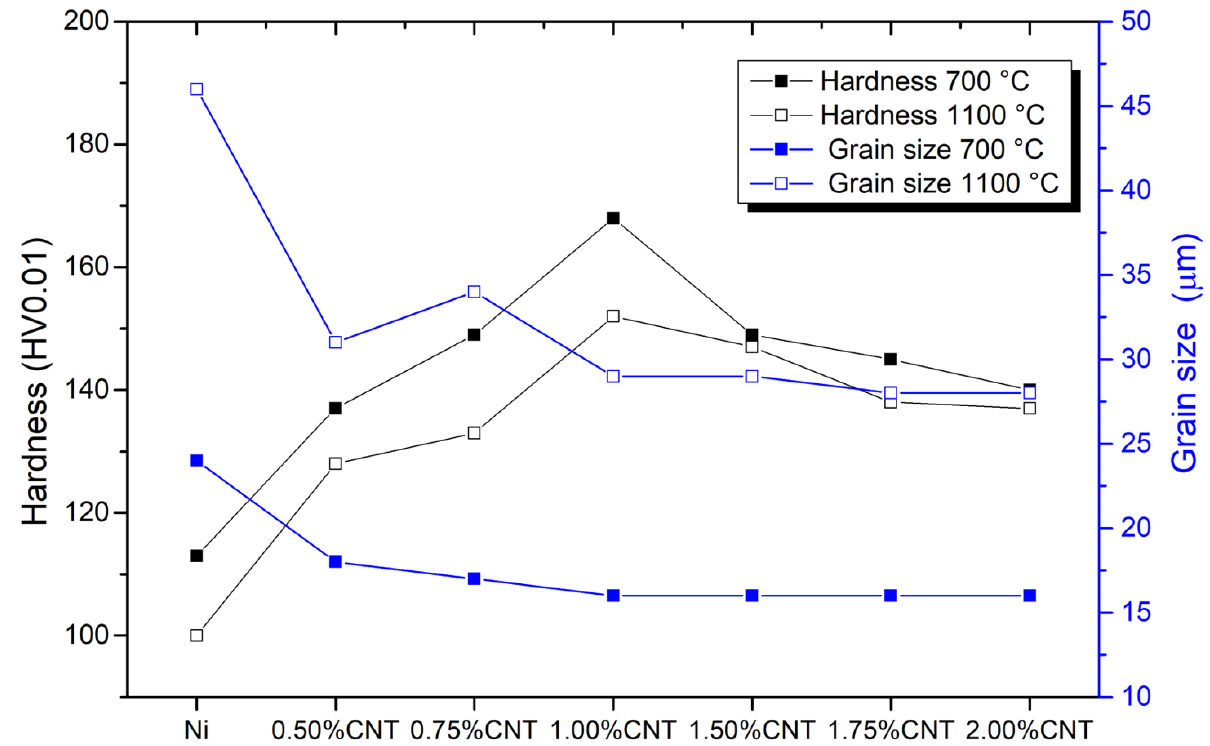
Figure 5. Hardness (HV0.01) and grain size (µm) evolution for Ni and nanocomposites heat-treated at 700 °C for 120 min and 1100 °C for 30 min.